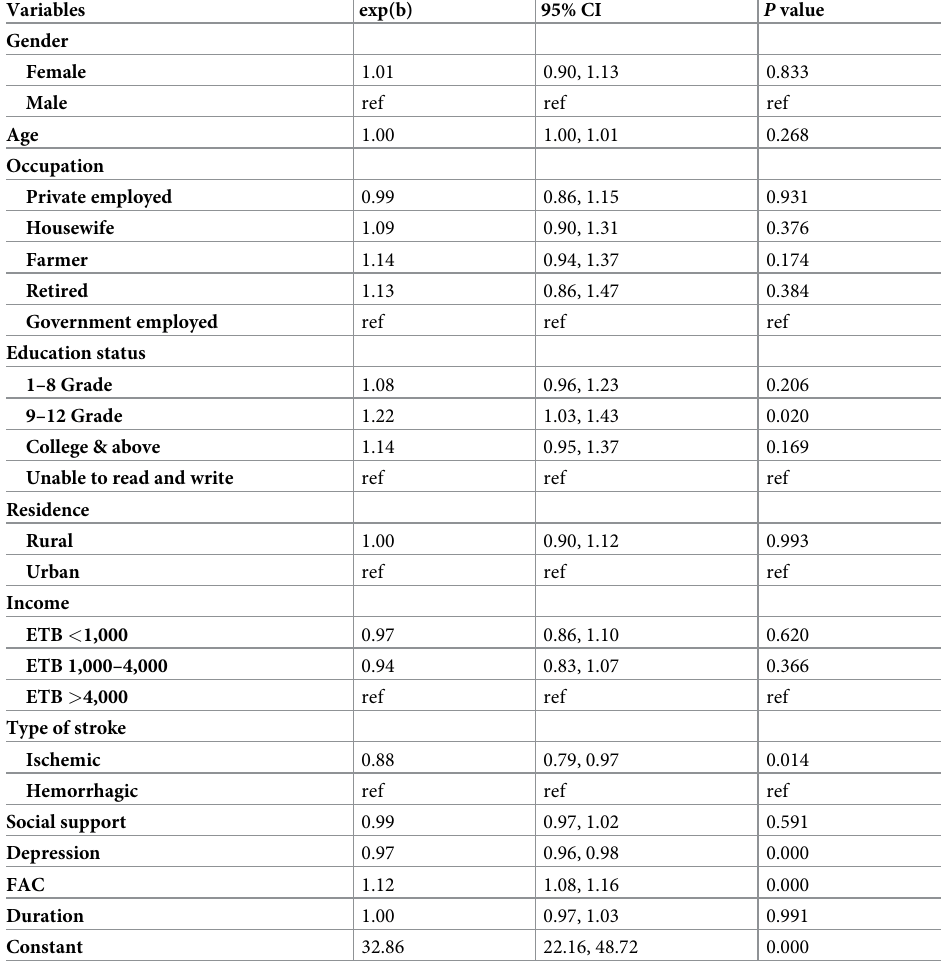
Table 4. Generalized linear model analysis to identify factors associated with MCS among patients with stroke (N = 180).